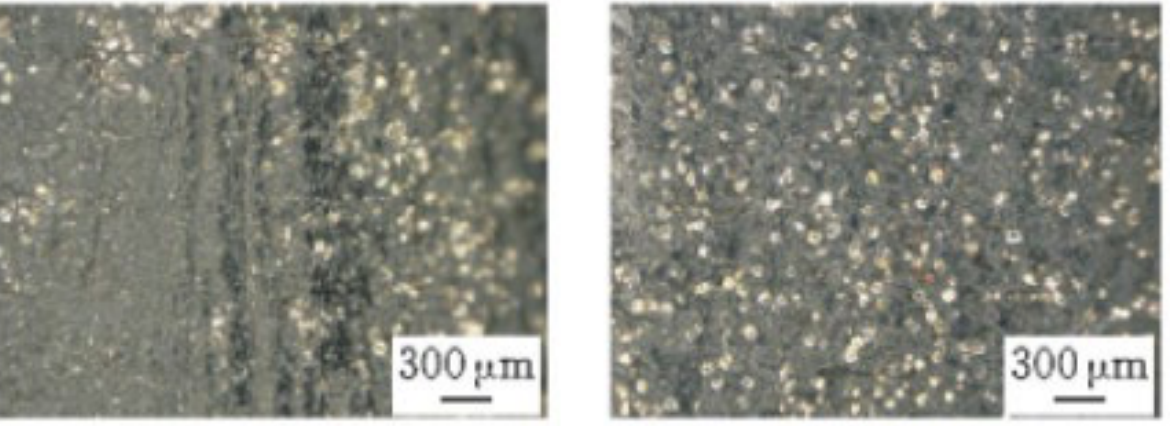
Figure 10. Comparison of grinding wheel surface morphology before and after grinding wheel dressing [34].